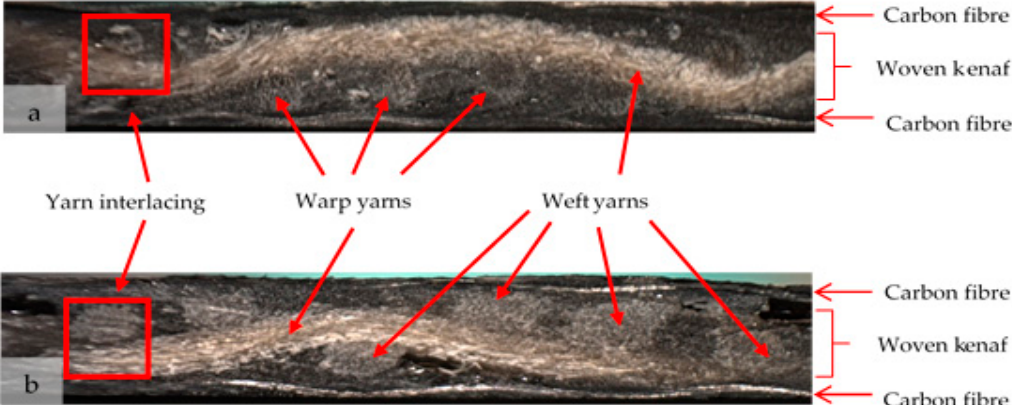
Figure 6. Cross section view of ( a ) warp direction and ( b ) weft view of laminated woven composite from satin fabric under optical microscope.